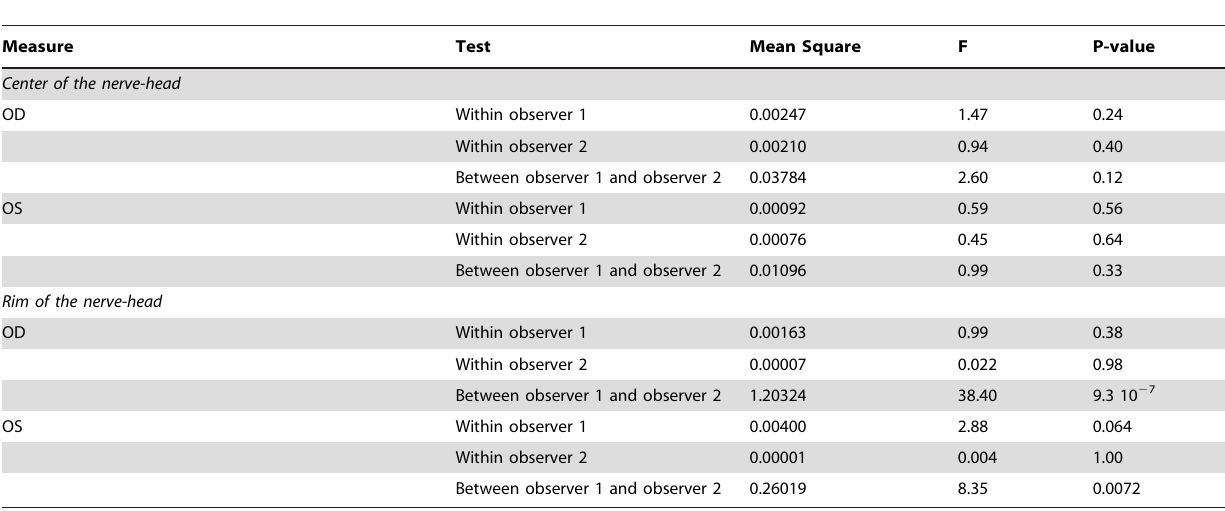
Table 3 . Intra- and inter-observer differences between nerve-head to fovea distance (NFD) measurements made from the center and the rim of the nerve-head in 30 right eyes (OD) and 30 left eyes (OS).